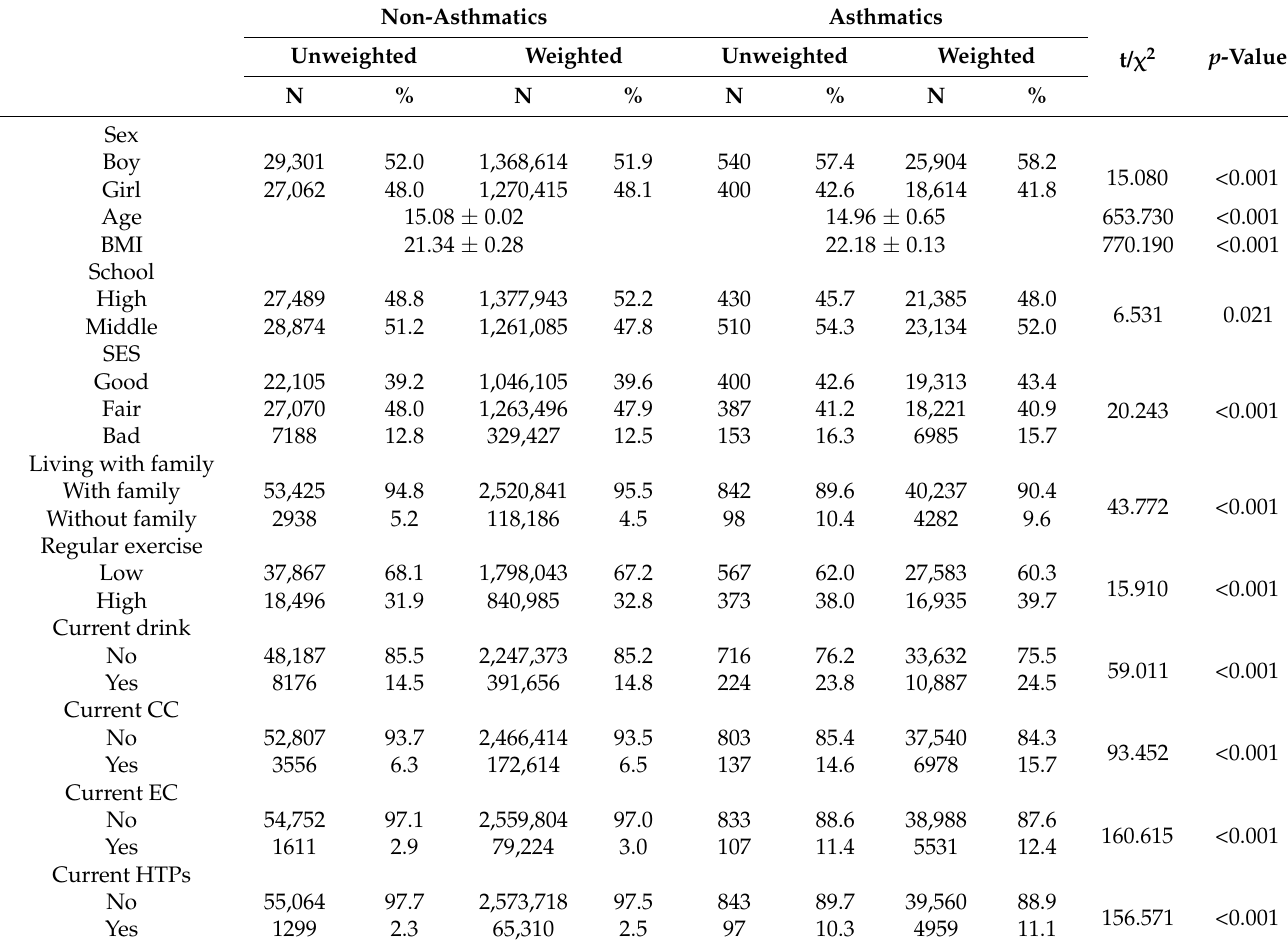
Table 1. General characteristics of study population.